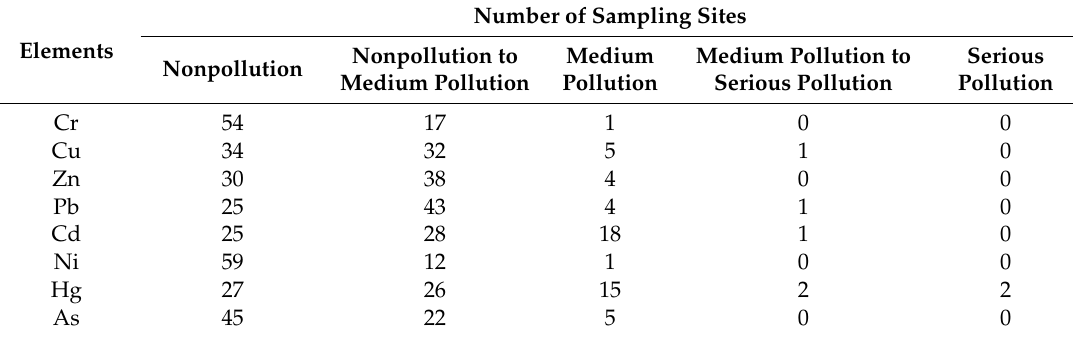
Table 10. Distribution of sampling points with di ff erent risk levels under ecological risk assessment by the geo-accumulation